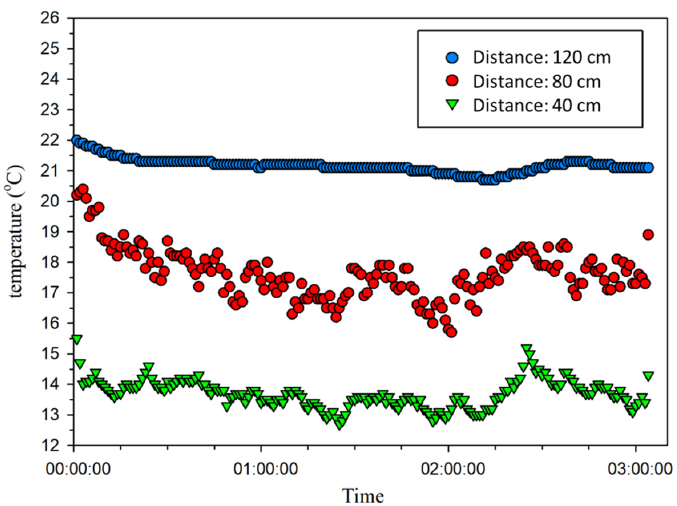
Figure 5. The measured temperature at the CSS middle aisle in the C-C’ section plane.